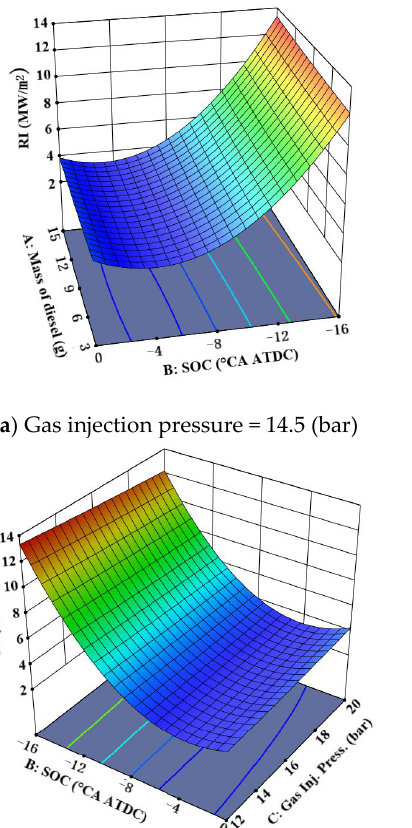
Figure 9. Response surface plot of the PFP.